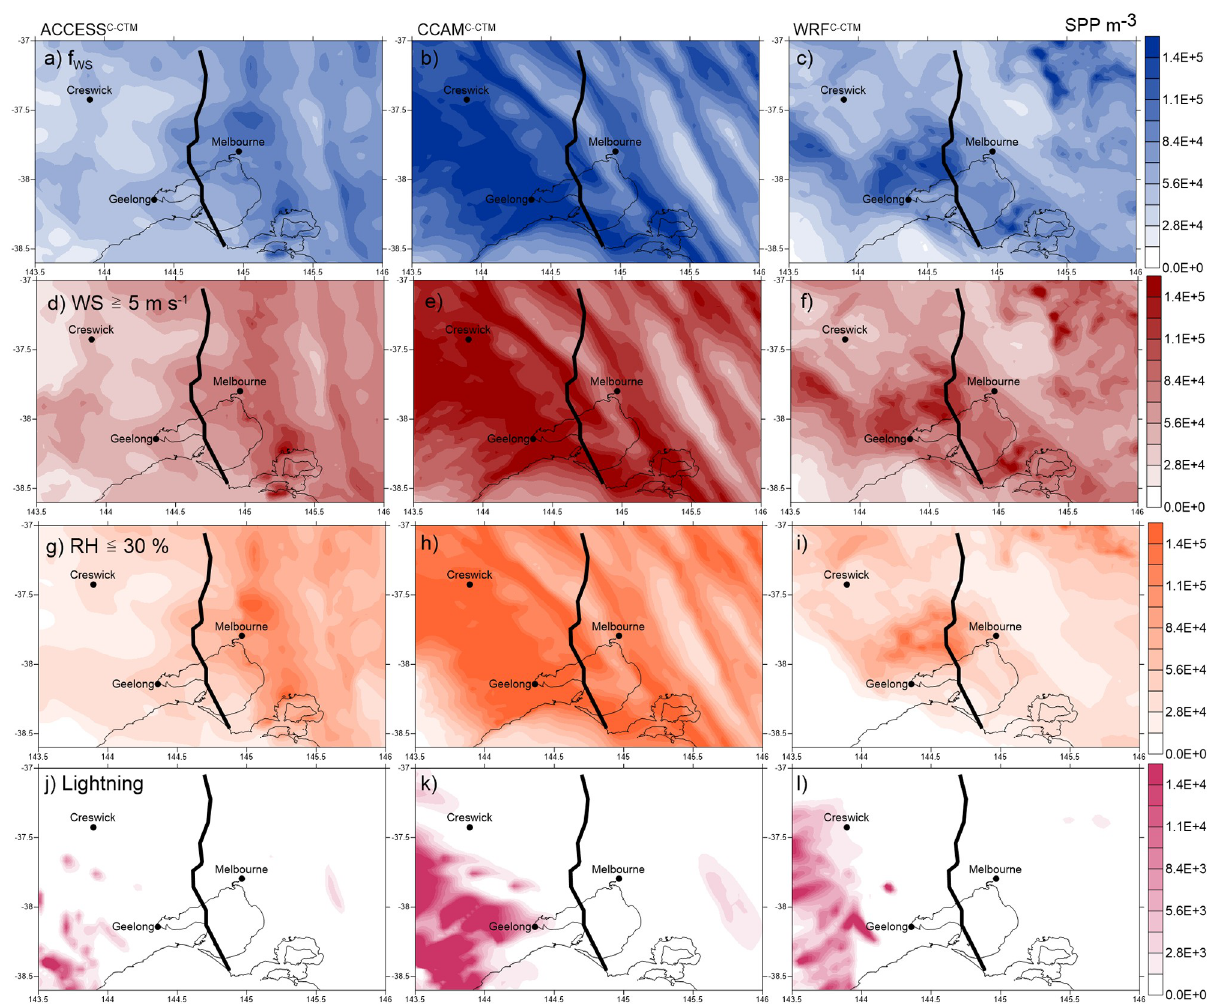
Fig 8. Sub-pollen particles (m -3 ) in the surface atmosphere at 06:00 UTC. Does not include mechanical rupturing. The heavy black line shows the approximate position of the storm front diagnosed from radar [19]. Panels (a-c) f WS , (d-f) WS > 5 m s -1 (g-i) RH < 30% and (j-l) lightning. Note the different scale for lightning colourbar. ACCESS C-CTM is shown in the left hand panels (a,d,g,j), CCAM C-CTM in the middle panels (b,e,h,k) and WRF C-CTM in the right hand panels (c,f,I,l). Basemap from Igismap.com